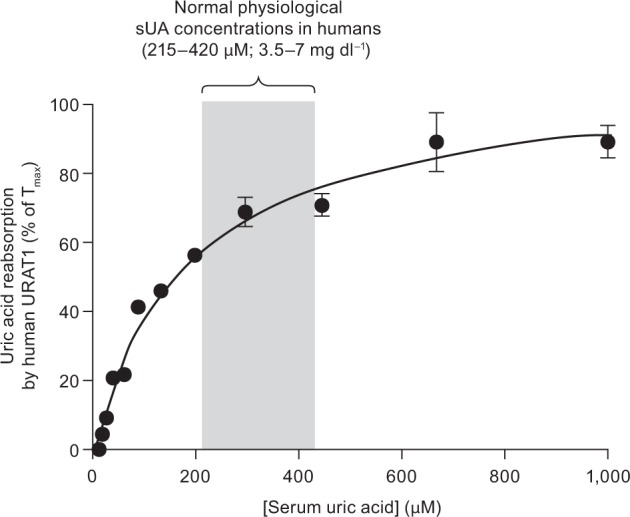
Human URAT1 evolution to regulate sUA levels. Results from figure 1a are shown, except the physiologic parameters of renal uric acid reabsorption and sUA concentrations are used to express the rate of uric acid transport relative to sUA concentration. At low uric acid levels (<215 µM), the high-affinity/low-capacity transporter is very active at uric acid reabsorption, whereas at high uric acid levels (>420 µM), the transporter is highly saturated and thus unable to transport most of the uric acid. This characteristic allows human URAT1 to more tightly control sUA levels. See Discussion for more details.